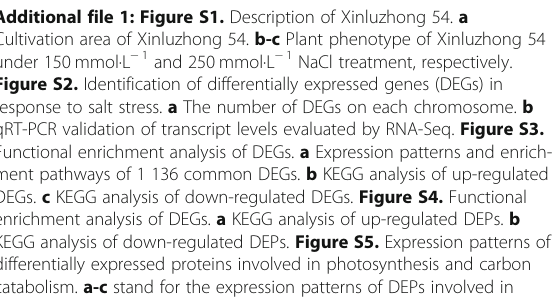
Additional file 1: Figure S1. Description of Xinluzhong 54. a Cultivation area of Xinluzhong 54. b-c Plant phenotype of Xinluzhong 54 under 150 mmol·L − 1 and 250mmol·L − 1 NaCl treatment, respectively. Figure S2. Identification of differentially expressed genes (DEGs) in response to salt stress. a The number of DEGs on each chromosome. b qRT-PCR validation of transcript levels evaluated by RNA-Seq. Figure S3. Functional enrichment analysis of DEGs. a Expression patterns and enrich- ment pathways of 1 136 common DEGs. b KEGG analysis of up-regulated DEGs. c KEGG analysis of down-regulated DEGs. Figure S4. Functional enrichment analysis of DEGs. a KEGG analysis of up-regulated DEPs. b KEGG analysis of down-regulated DEPs. Figure S5. Expression patterns of differentially expressed proteins involved in photosynthesis and carbon catabolism. a-c stand for the expression patterns of DEPs involved in